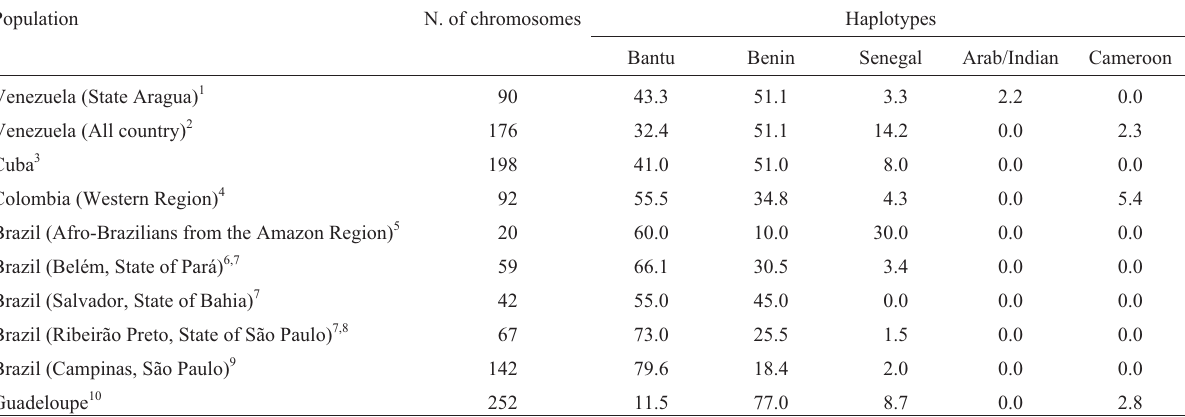
Table II - Frequency distribution (%) of the typical β S haplotypes in patients from Iberoamerican populations and the Guadeloupe Island.